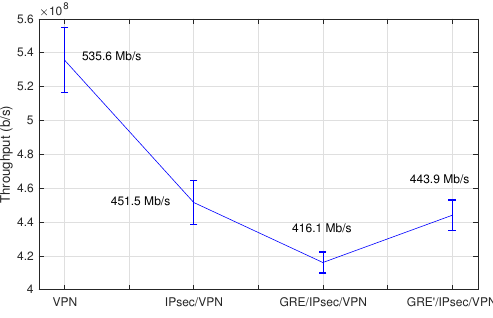
Figure 5. Performance evaluation of GRE/IPsec tunnel